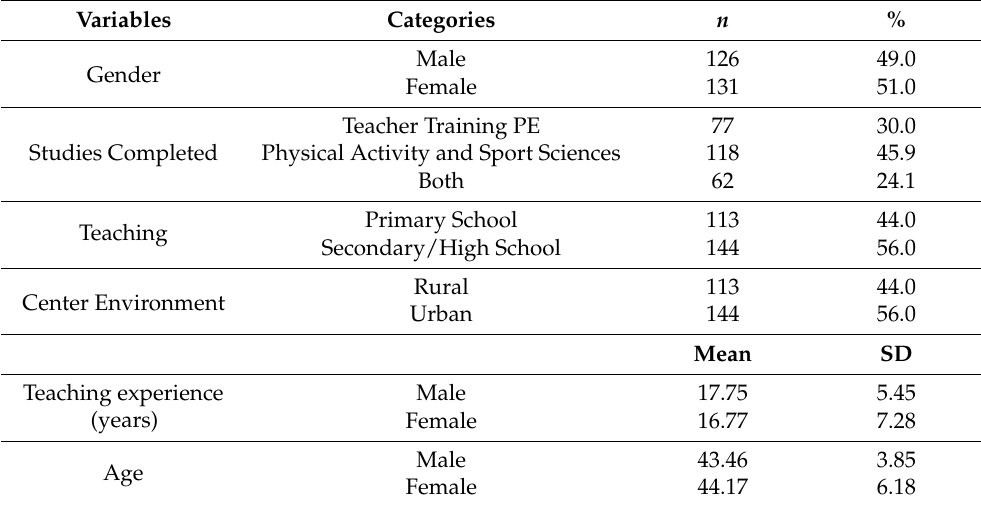
Table 1. Frequency distribution of the sample ( n =